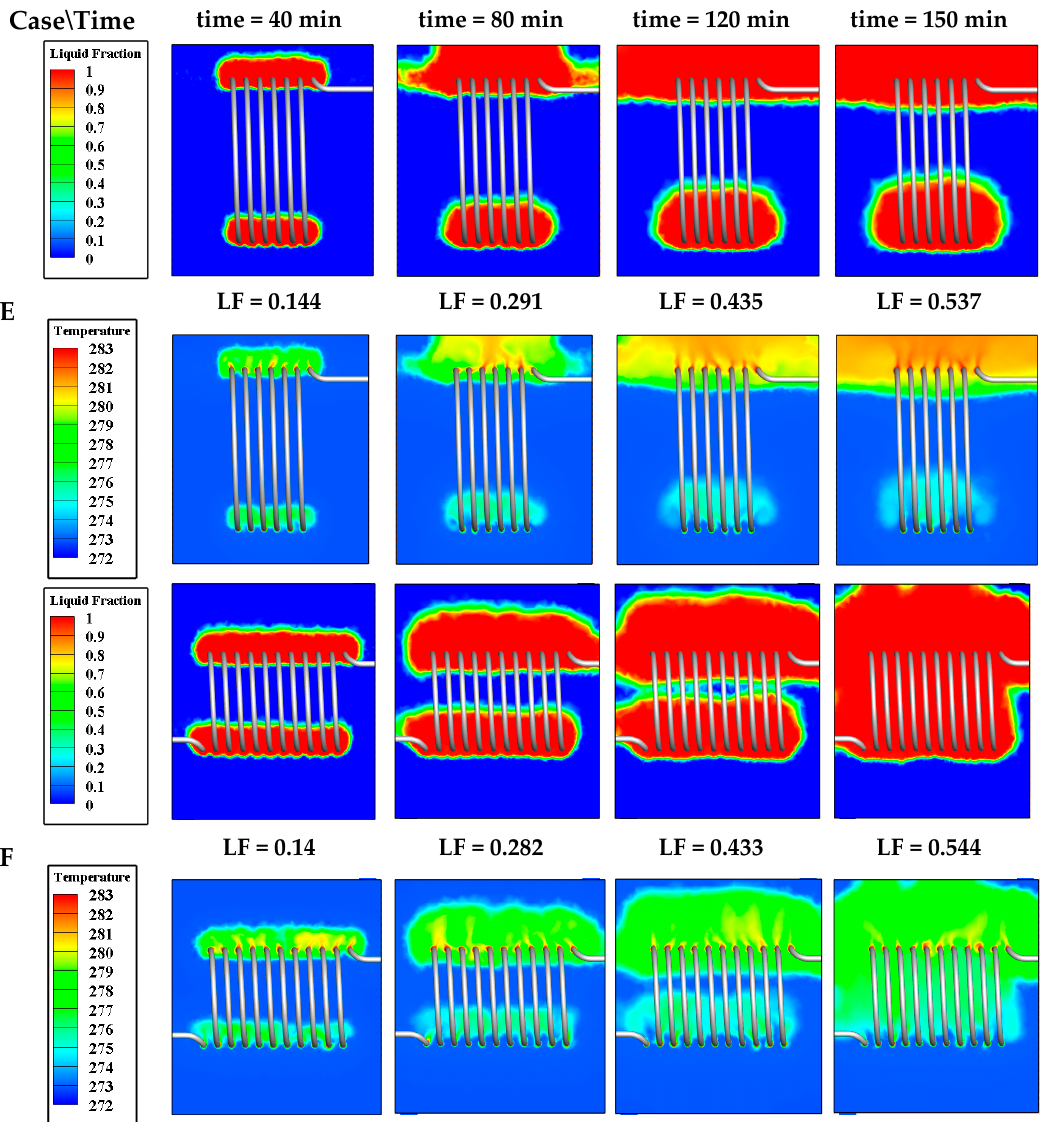
Figure 17. Contours of the liquid fraction and temperature for cases E and F at four different times in the plane x = 0.